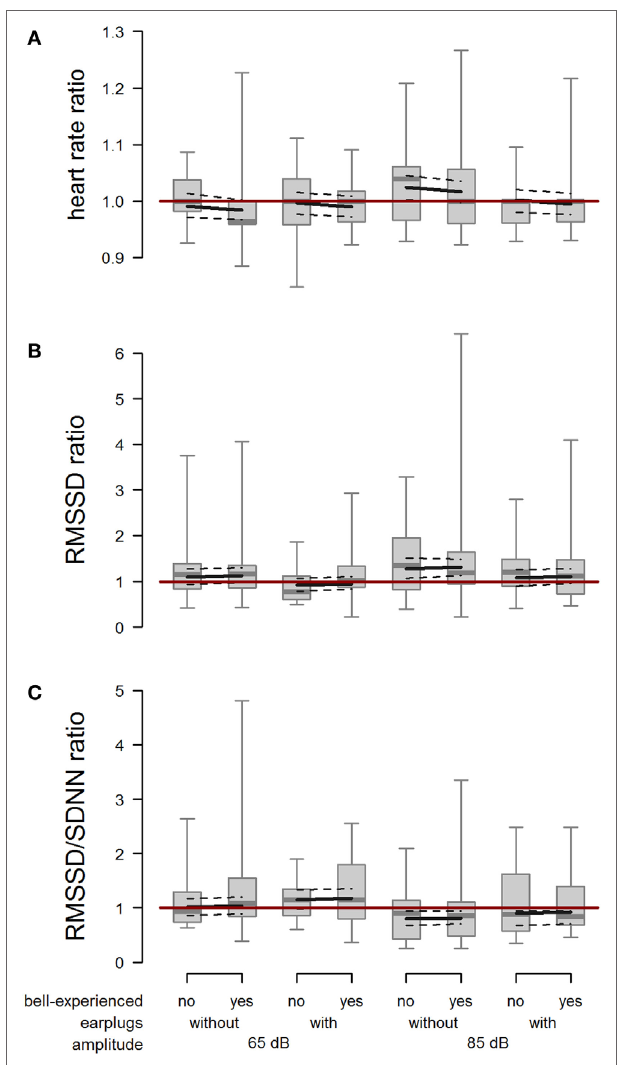
FigUre 6 | Heart rate, root mean square of successive difference (RMSSD), and RMSSD/standard deviation of heartbeats (SDNN). Ratio of (a) heart rate, (B) RMSSD, and (c) RMSSD/SDNN between playback and reference situation depending on bell-experienced (no, yes), earplugs (without, with), and amplitude (65, 85 dB). Descriptive data are presented as box plots indicating observed median, first and third quartiles, and absolute range of data. Solid lines show the model estimation, and dotted lines the lower and upper 95% confidence intervals. The dark red line represents the ratio value in case of identical values during trial and